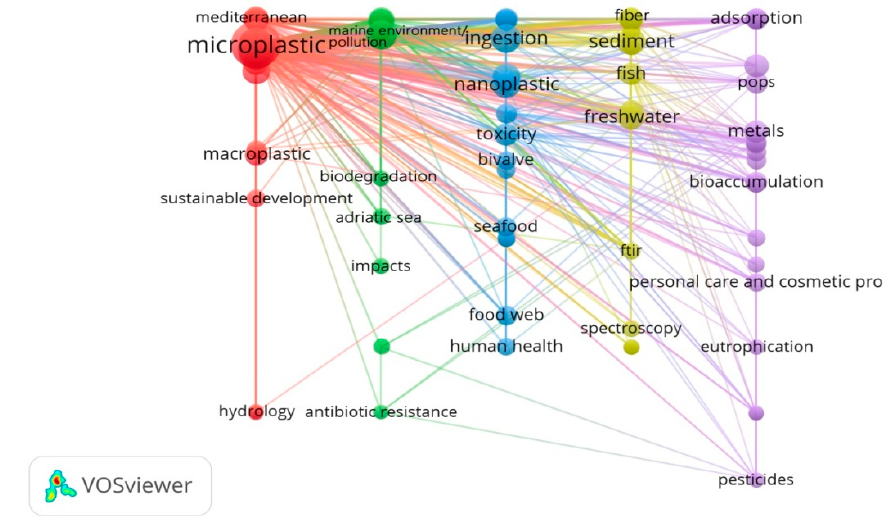
Figure 4. Co-occurrence network diagram of author keywords, appearing in a minimum of five publications between 2004 and 2019.